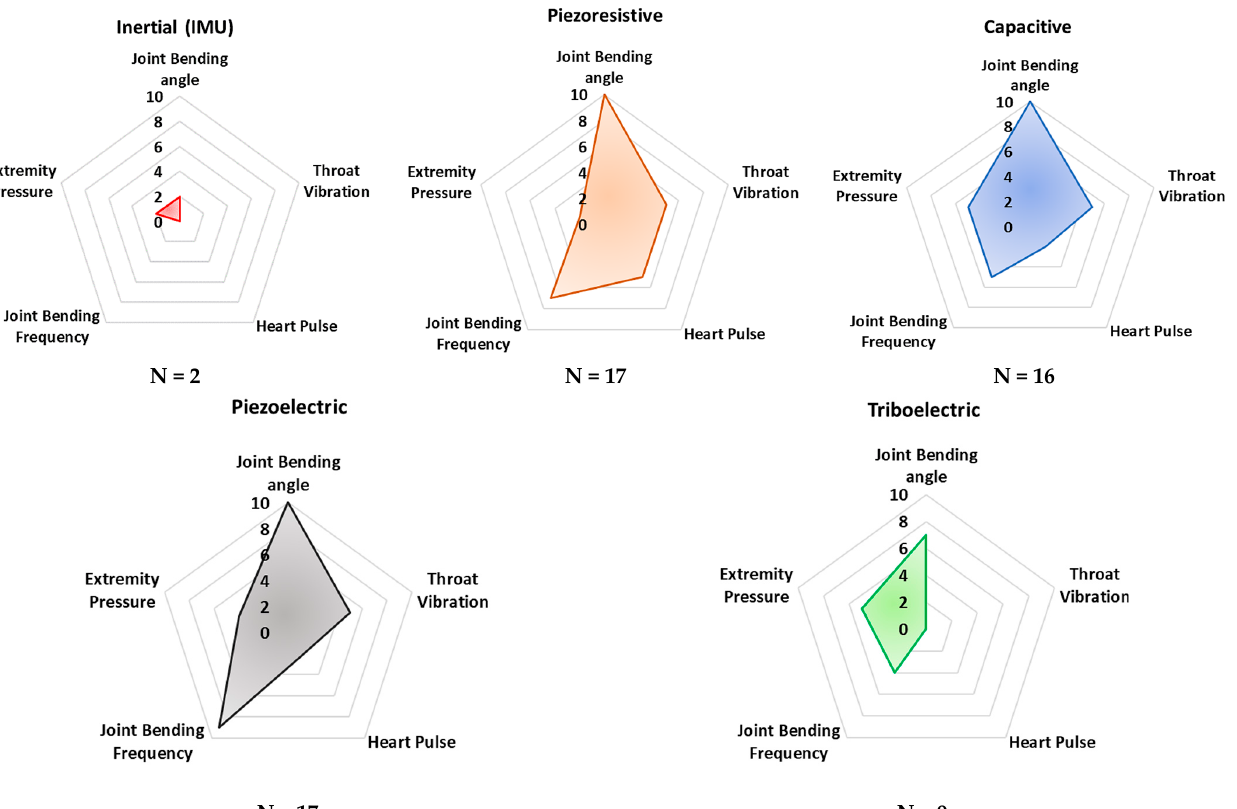
Figure 7. Radar charts for comparison of the main transduction mechanisms to monitor human bio– physical parameters according to the area of sensor application on the body. The scale (0 − 10) indi- cates the “frequency” with which a specific sensing technology is applied for monitoring a given body area. Additionally, the analyzed population (N) is reported for each sensing technology.